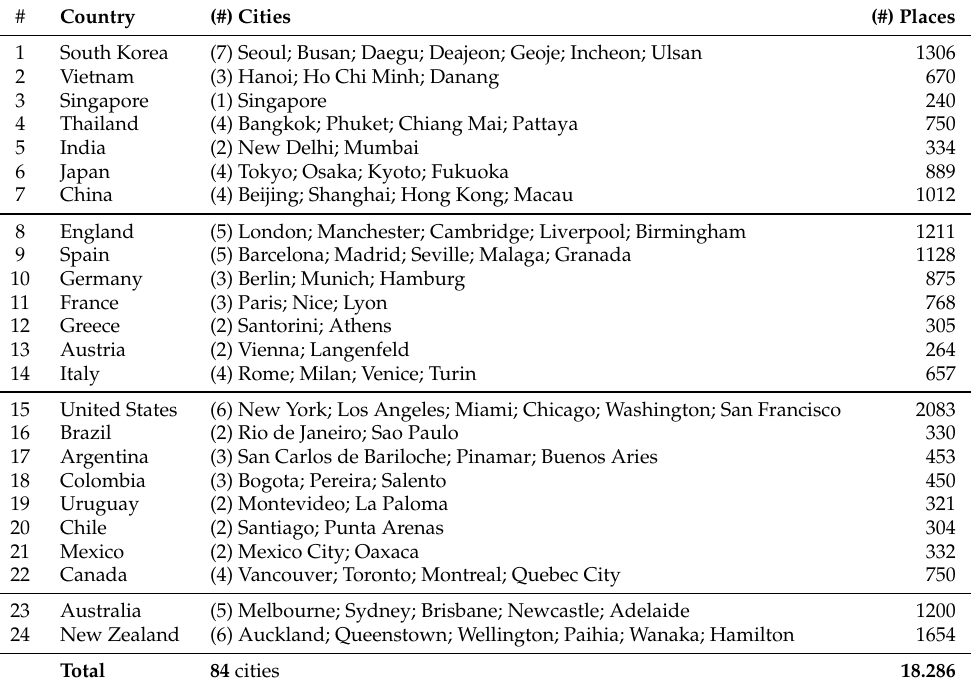
Table 2. The statistics of tourist places data in our OurPlaces